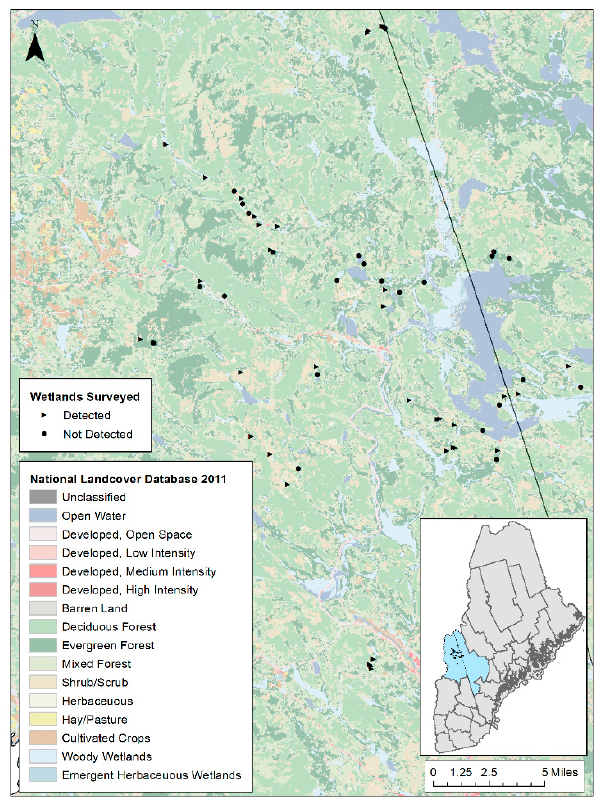
Figure 1. Land cover classes of the study area and digitized polygons of wetlands where Rusty Blackbirds were detected (black triangles) or were not detected (black circles) in northern New England, USA, with 500 m buffer circles showing habitat in